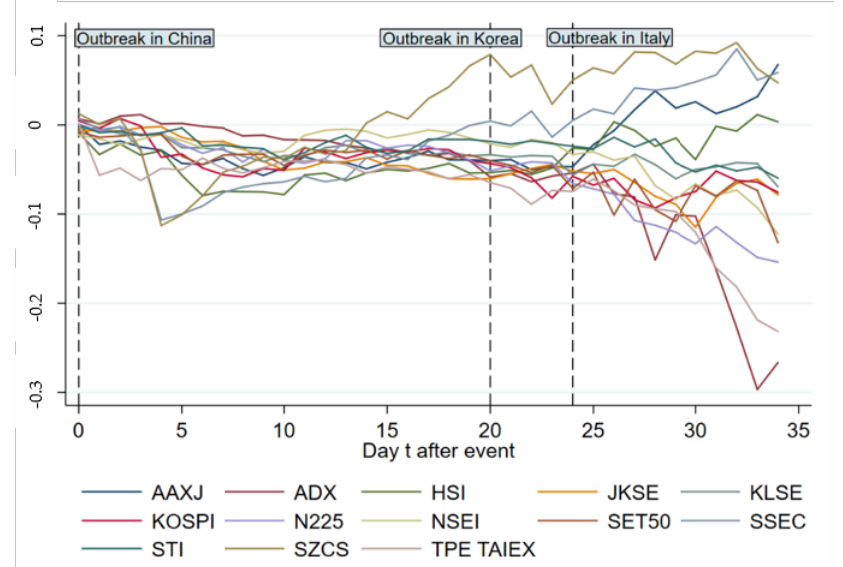
Figure 3. Cumulative abnormal return (CAR) change of main indices in Asia from day 0 to 34.